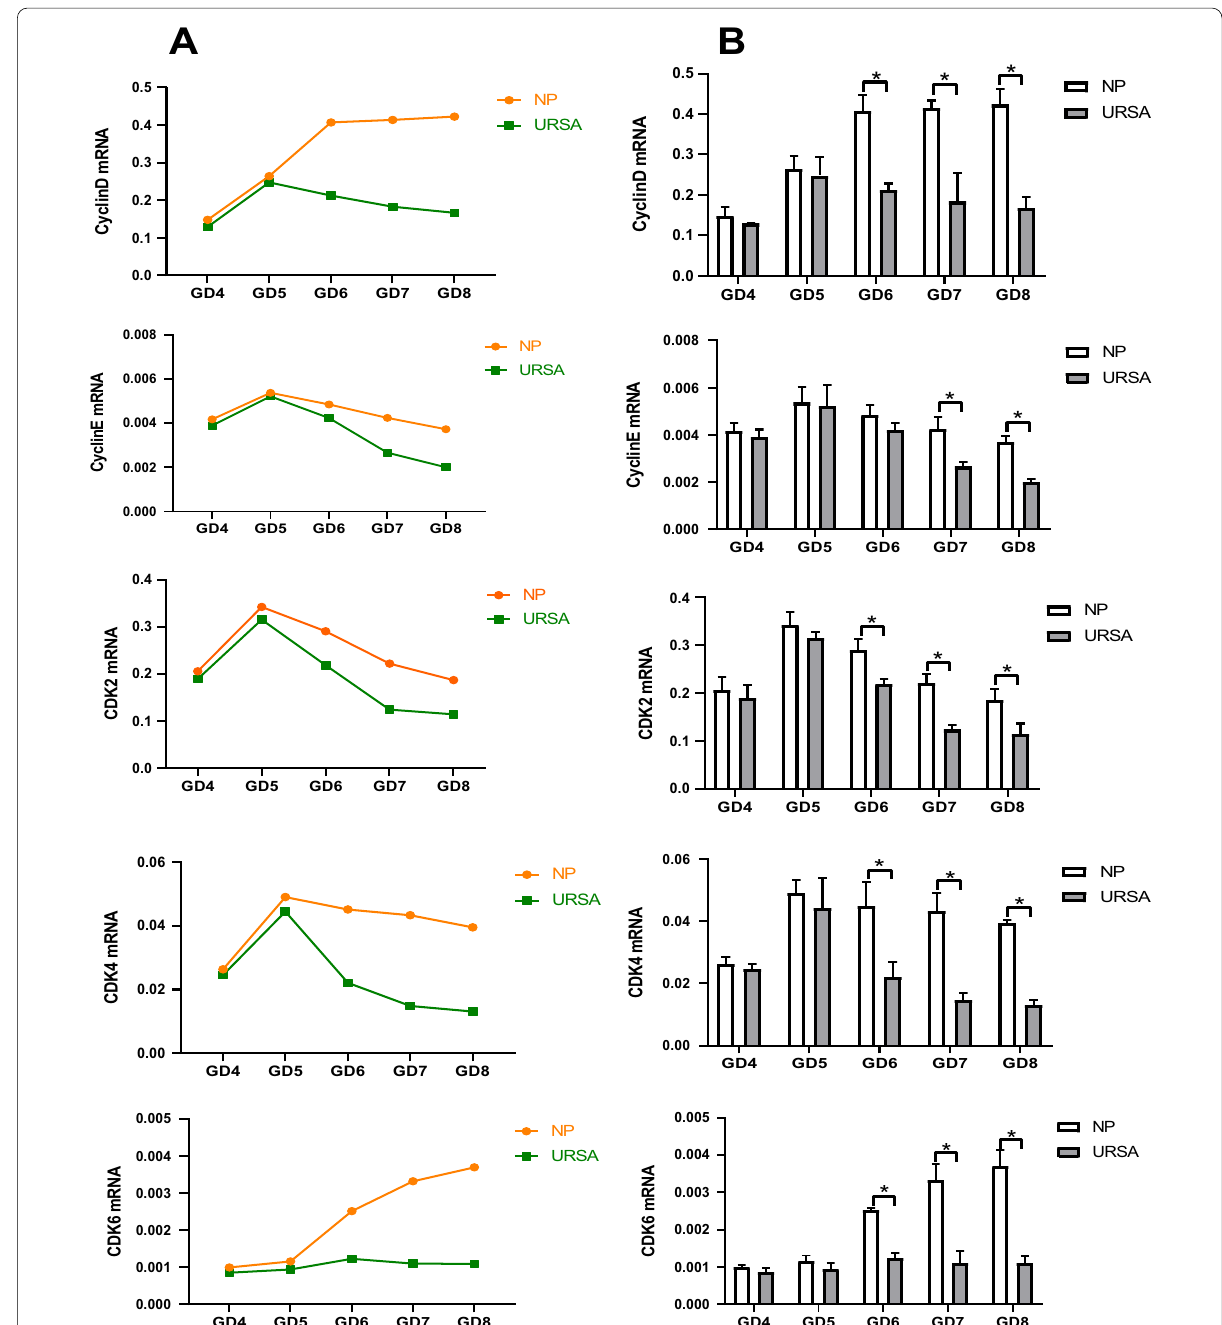
Fig. 3 The indexes gene expression of Cyclin‑CDK in decidual tissues of NP group and URSA groups (mean the cell cycle regulatory genes cyclin D, cyclin E, CDK2, CDK4, CDK6 and of the control gene GAPDH from GD4‑GD8 in the NP and URSA groups. A The line charts on the left show the temporal changes of gene expression from GD4 to GD8. B The bar graphs on the right show the mRNA expression difference in decidual tissues between the two groups on GD4‑GD8. (n different (p <